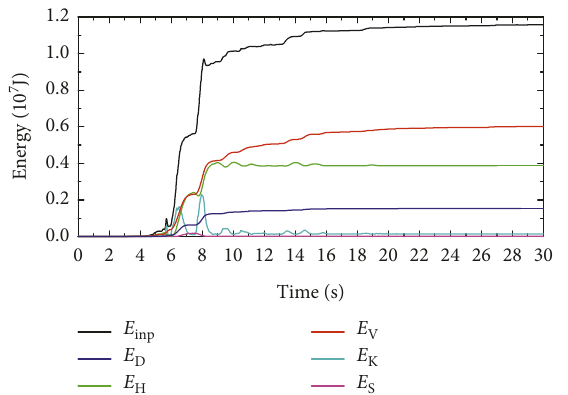
Figure 16: Time history response of energy for the steel frame with VDs under the pulse-type excitation of record